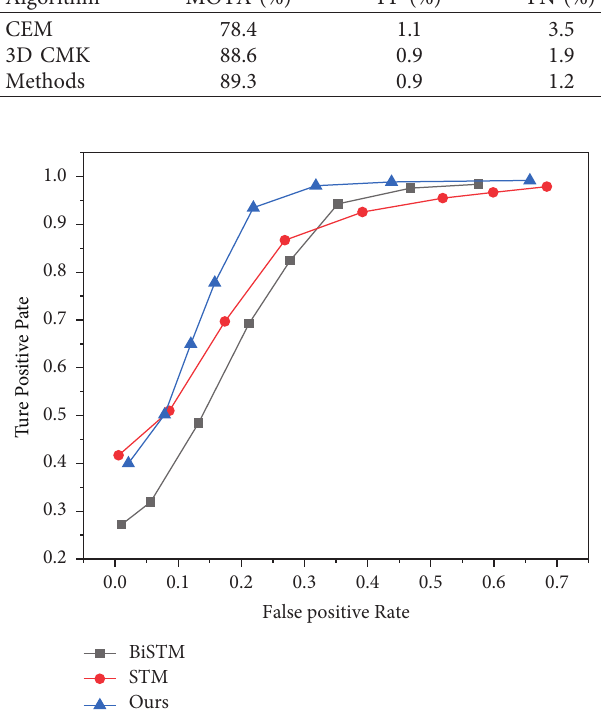
Table 1: Experimental comparison of tracking effect. Algorithm